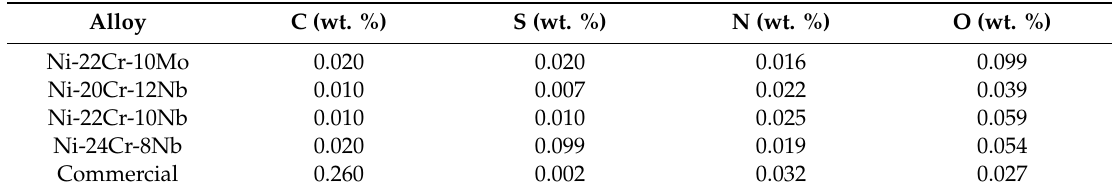
Table 2. Interstitial contents (wt. %) measured by LECO combustion analyses of the Ni-Cr-Nb and Ni-Cr-Mo alloys. Alloy C (wt. %) S (wt. %) Alloy